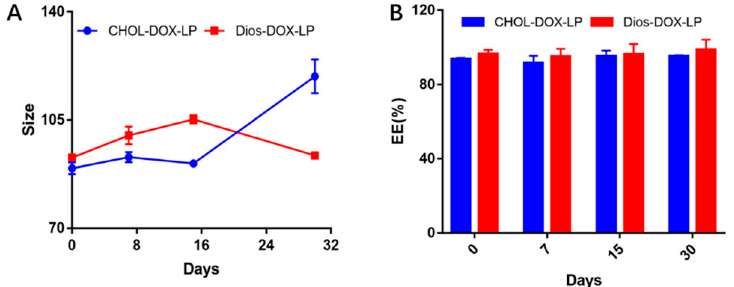
Figure 3. ( A )The comparison of particle size between CHOL-DOX-LP and Dios-DOX-LP in 30 days; ( B ) The comparison of EE between CHOL-DOX-LP and Dios-DOX-LP in 30 days.